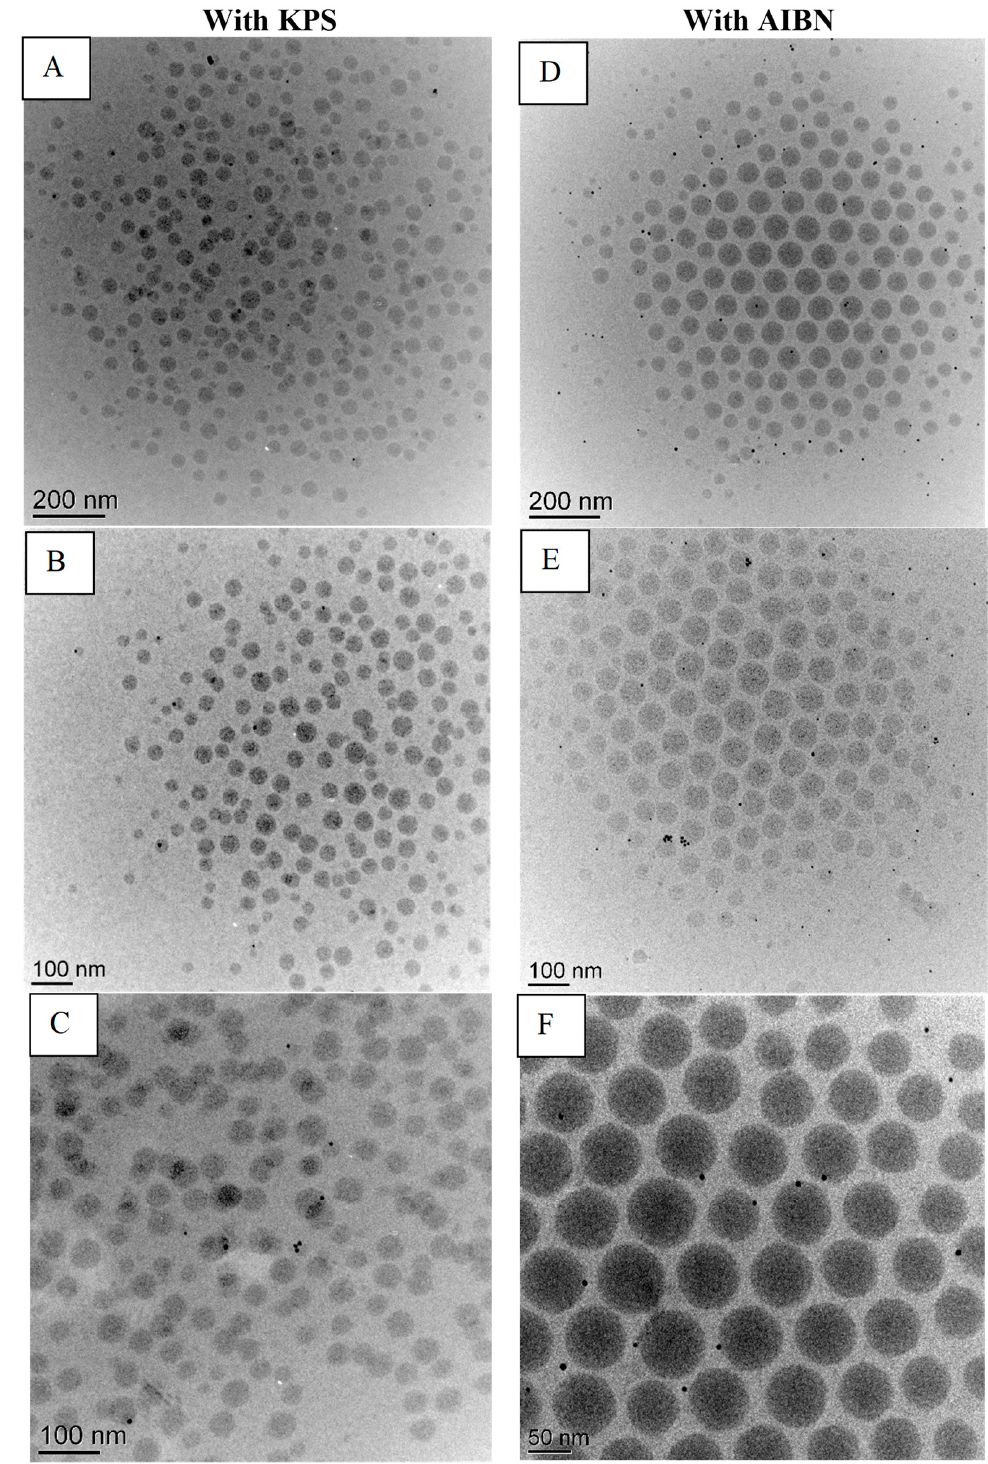
Figure 1. Cryo-TEM micrographs of latexes containing AgNPs prepared with KPS ( A – C ) or AIBN ( D – F